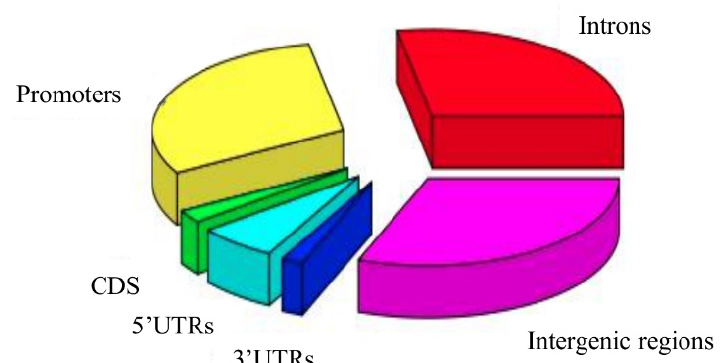
Figure 4. Distribution of 14,266 rSNPs across human genomic regions.